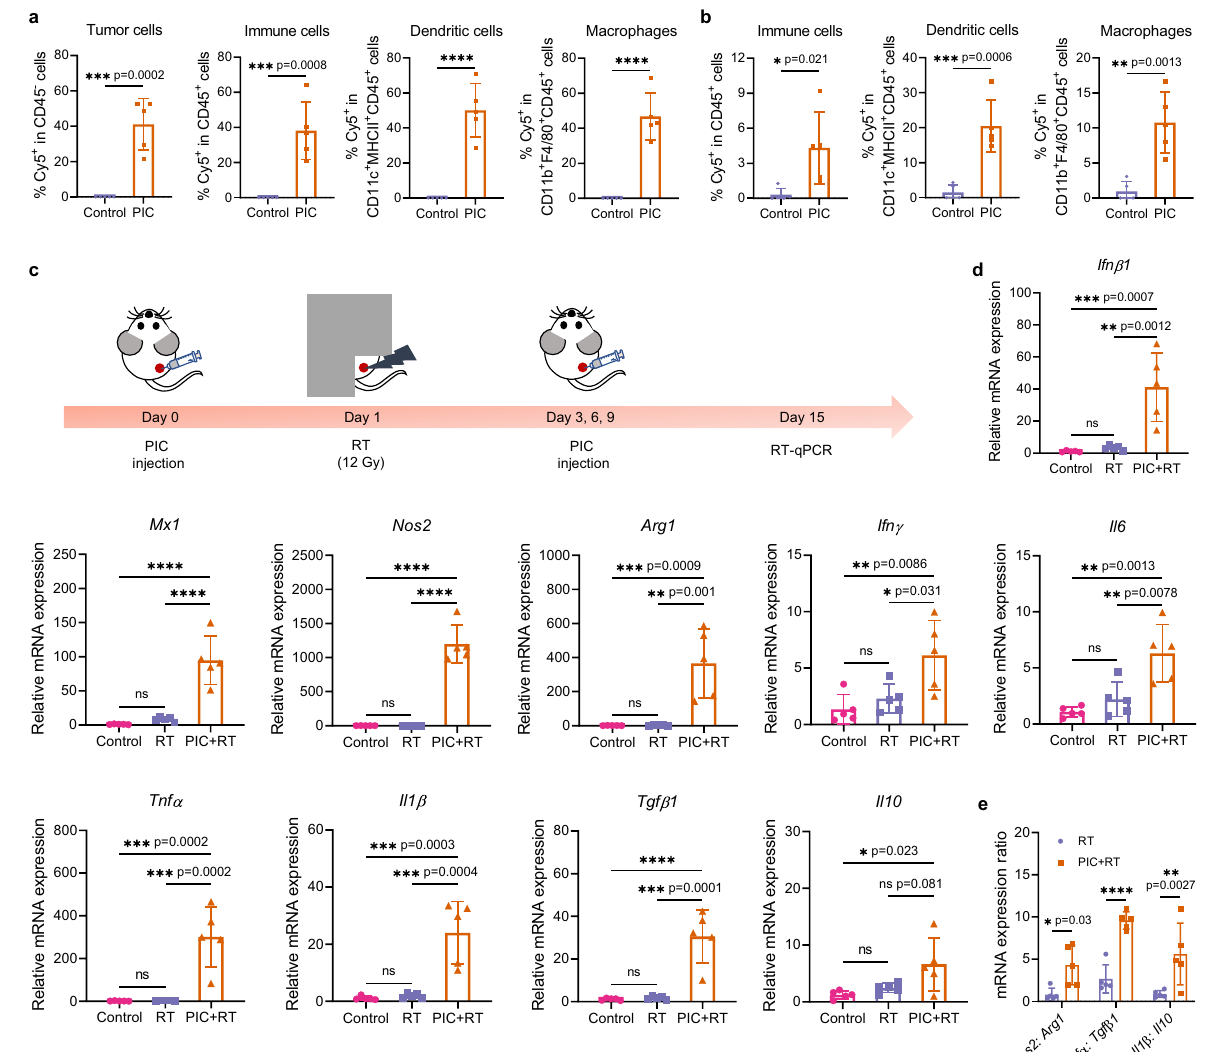
Fig. 3 | The biodistribution and immunomodulatory effects of PIC in vivo. The cellular uptake of Cy5-PIC in different cells within the a tumors and b TDLNs after the Cy5-PIC was intratumorally injected into B78 melanoma bearing mice. ( n =5 biologically independent samples). The gating strategy is provided in Supple- mentary Fig. 13 in Supplementary Information. c Scheme for the study of the immunomodulation effectof PIC+RTon the B78 tumor microenvironment. d The mRNA expression of select in fl ammatory and anti-in fl ammatory genes ( Ifn β 1 , Mx1 ,